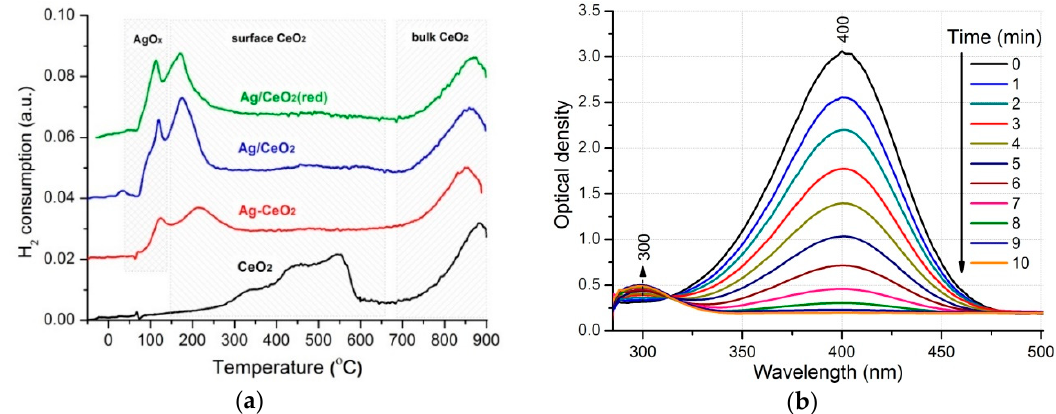
Figure 5. The H 2 -TPR profiles for CeO 2 and catalysts ( a ), and UV-vis spectra during the reduction of p-nitrophenol over Ag-CeO 2 catalyst ( b ).